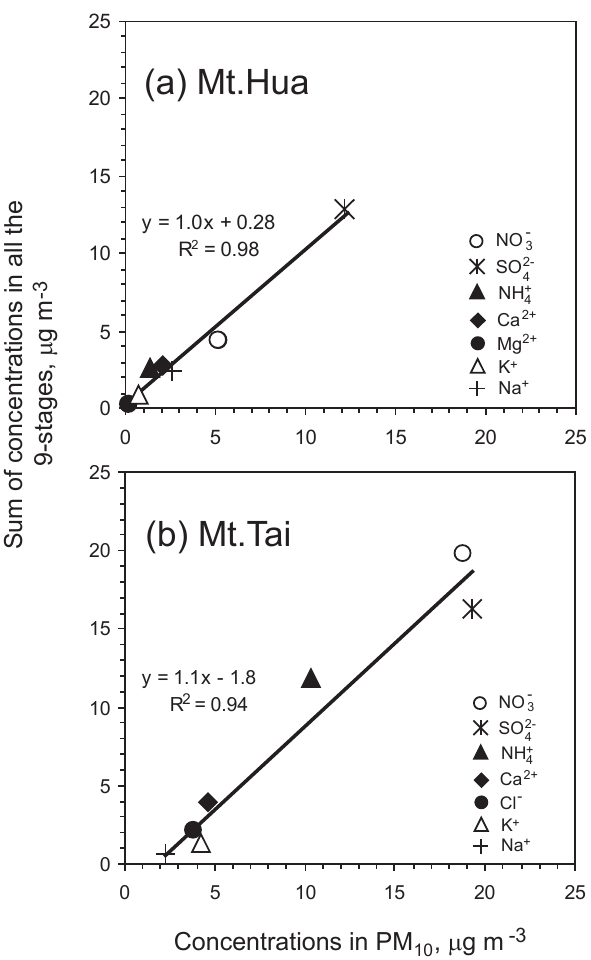
Fig. 2. An intercomparison of major components measured by the PM 10 and 9-stage Fig. 2 Comparison of data measured by the 9-stage Andersen sampler and the PM 10 sampler at the two mountain sites